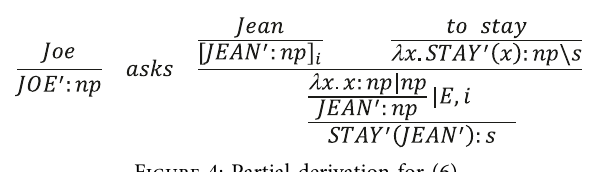
Figure 4: Partial derivation for